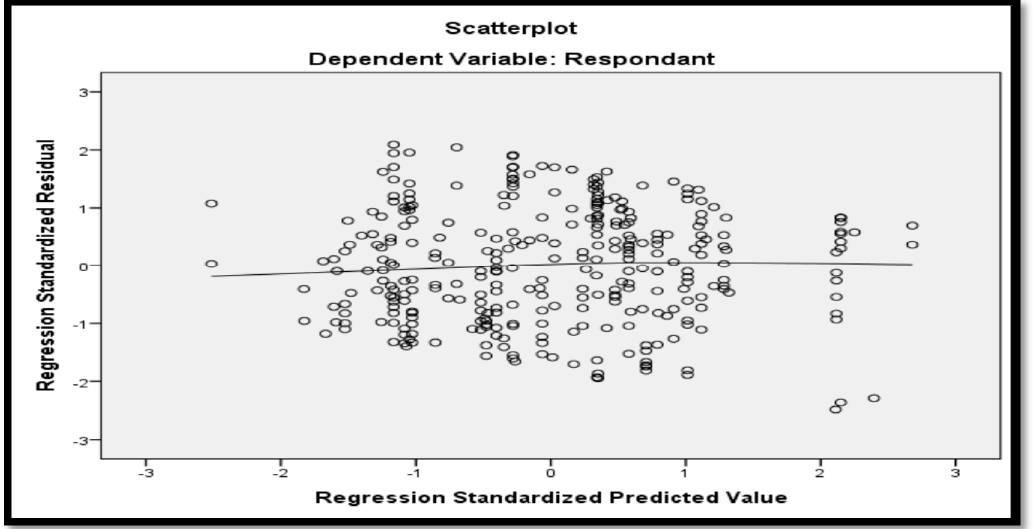
Figure 9. Homoscedasticity of the sample (Source: Sample data complied through SPSS).